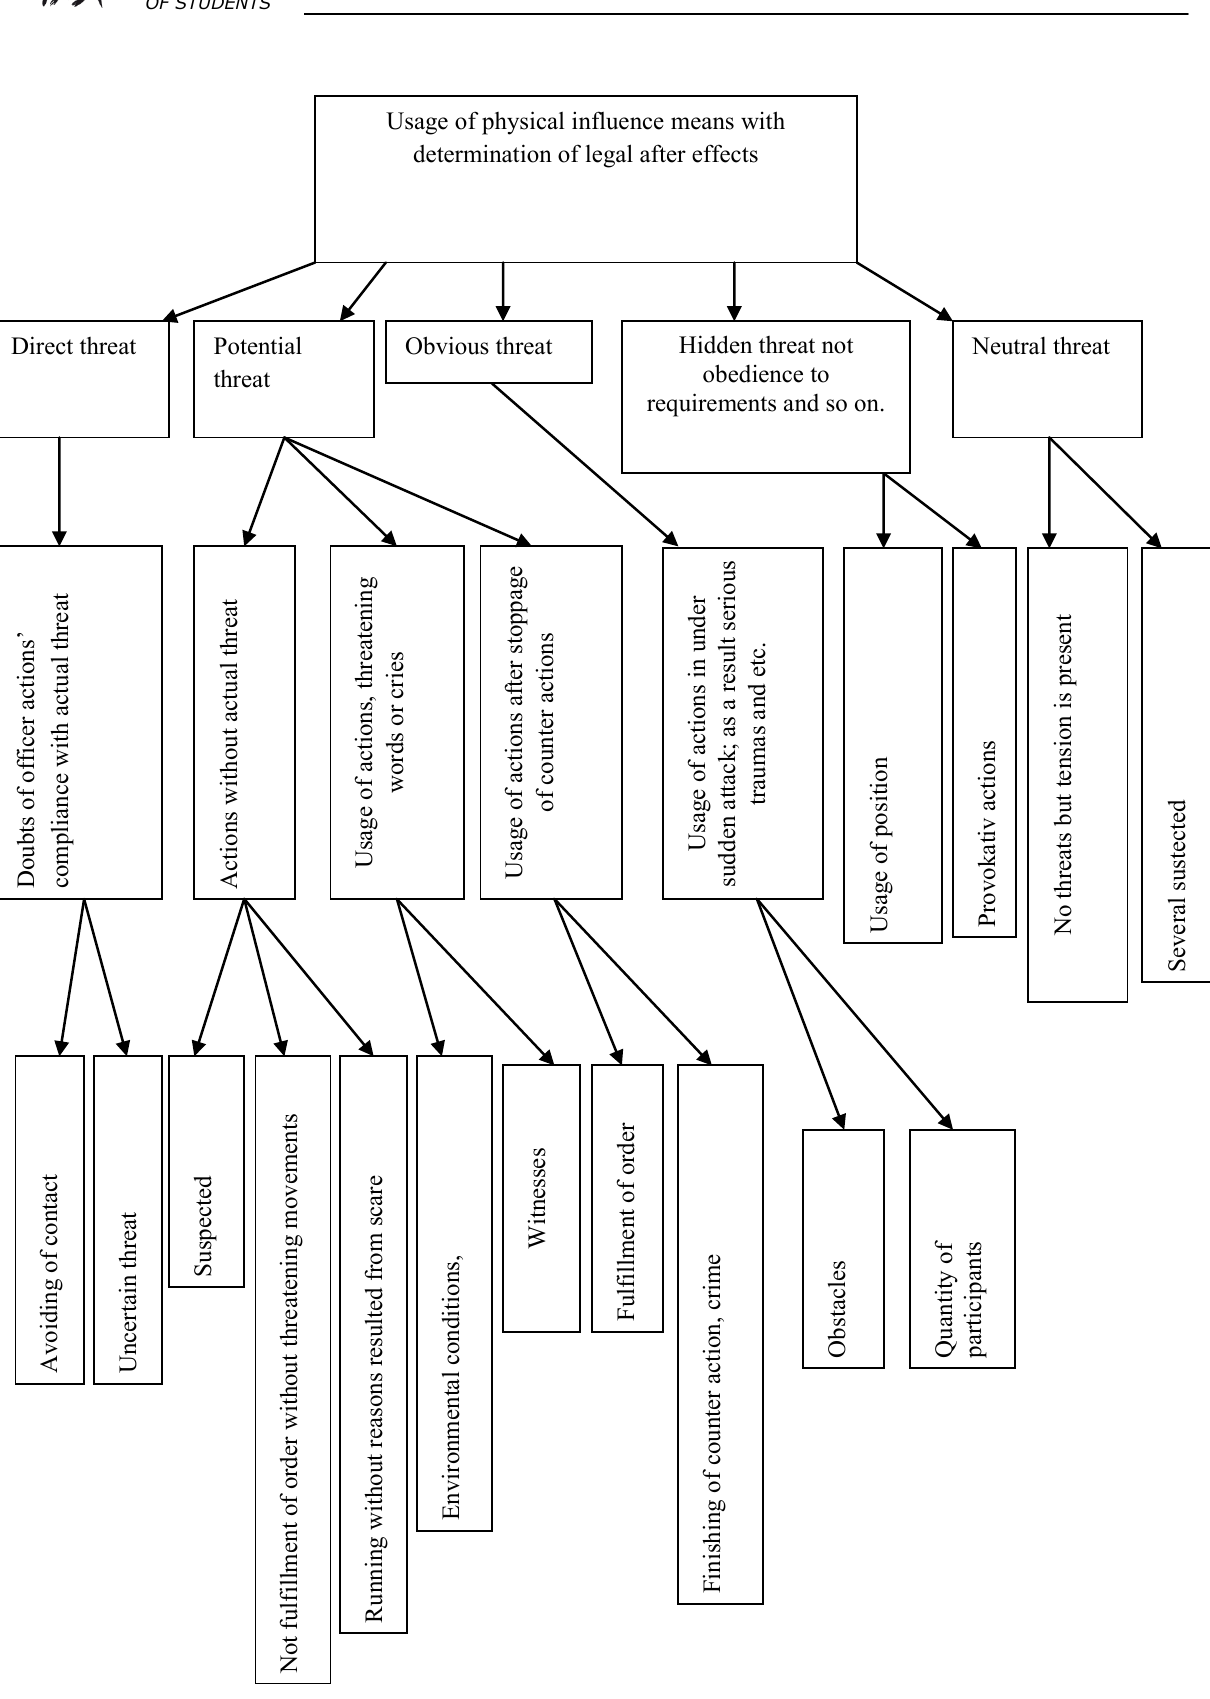
Fig.2. Determination of legal after effects in conditions of danger of different levels